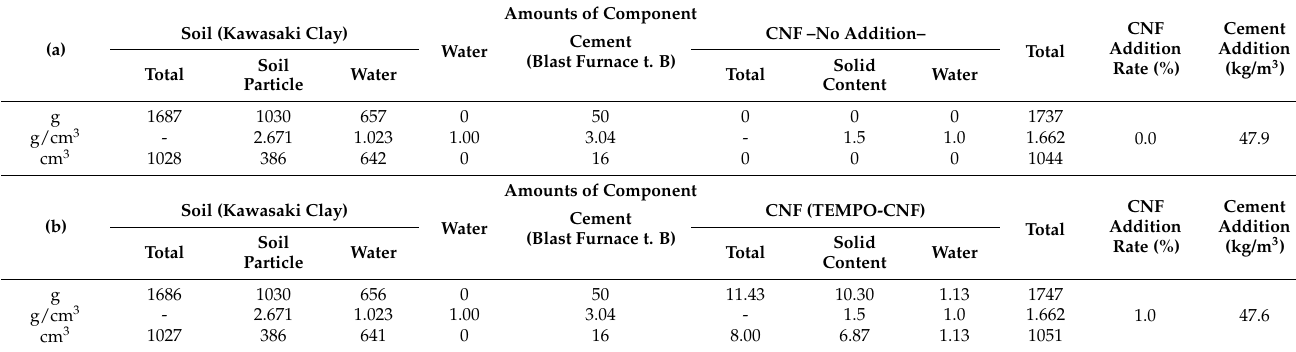
Table 4. Mix proportion of cement, CNF, water, and soil in Method 2 for evaluating variability: ( a ) Treated soil without CNF; ( b ) Treated soil with TEMPO-CNF (Powder).